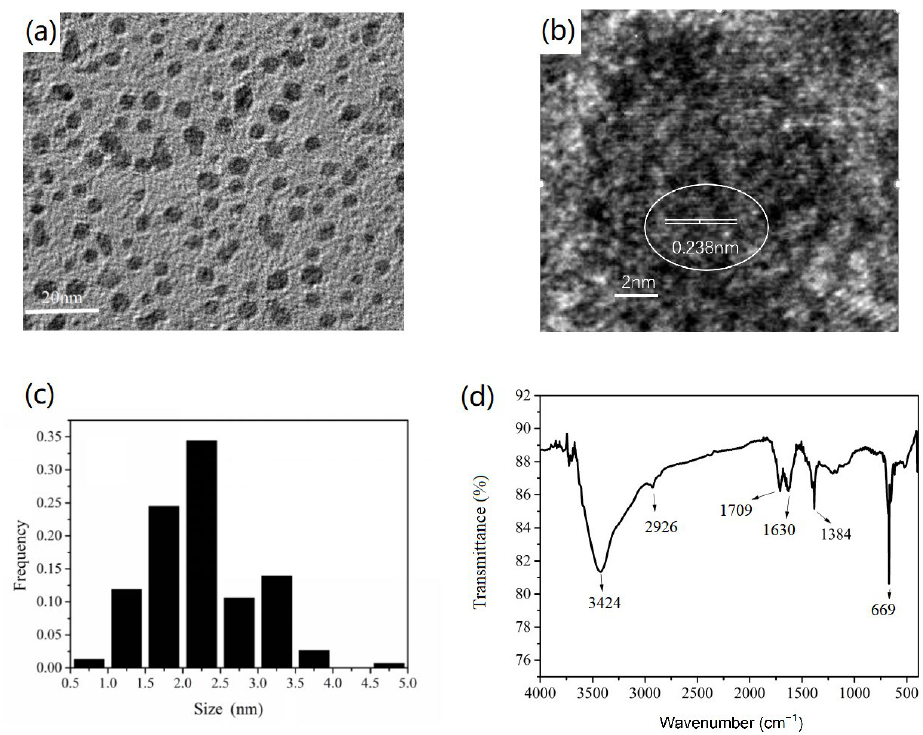
Figure 6. The TEM image ( a ), HRTEM image ( b ), particle-size distribution ( c ), and IR spectrum ( d ) of CQDs based on WRN.